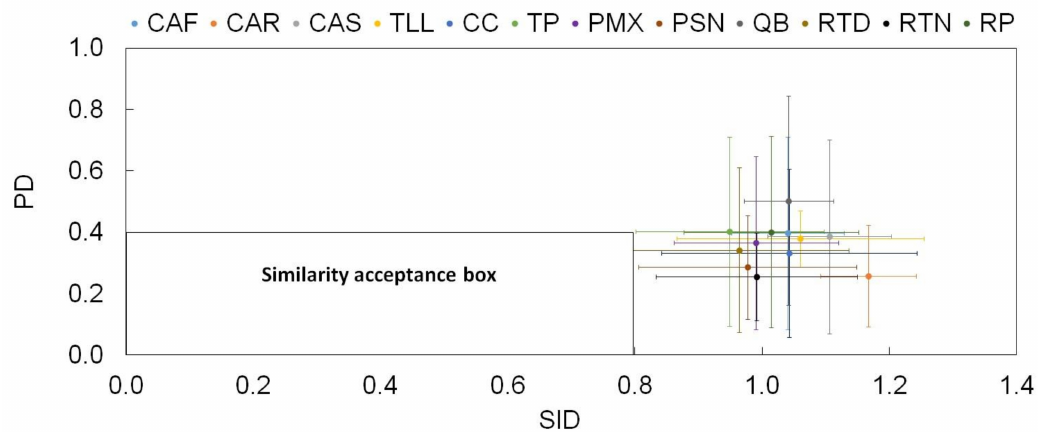
Figure 10. Similarity test among the source emission profiles based on the PD and the SID as per Belis and Pernigotti [59]. The bars represent the range values for each parameter among source profiles. Definition of source profile codes are presented in Table 1.